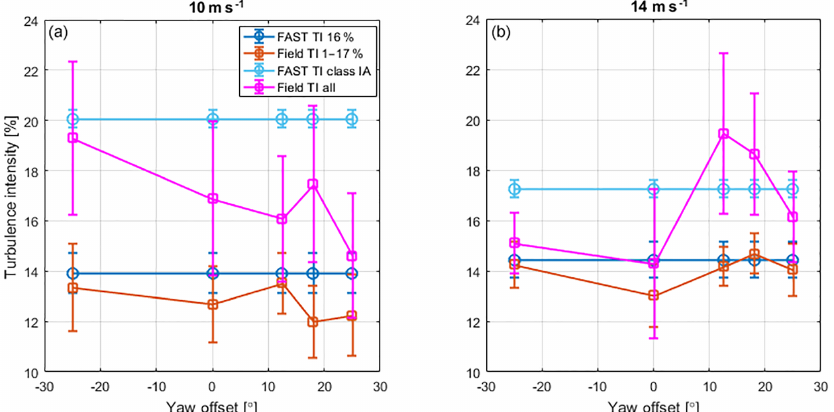
Figure 10. Comparison between simulated (circles) and measured (squares) values of TI as a function of yaw offset for two wind-speed bins of interest ( a : U hub = 10ms − 1 ; b : U hub = 14ms − 1 ). The field data are shown when including all data (label “All” in the legend) and when filtering for TI below 17% (label “TI 1–17%” in the legend). The simulated data are shown for class IA turbulence (IEC, 2005) (label “FAST TI Class IA” in the legend) and for TI = 16% at 15ms − 1 (label “FAST TI 16%”).